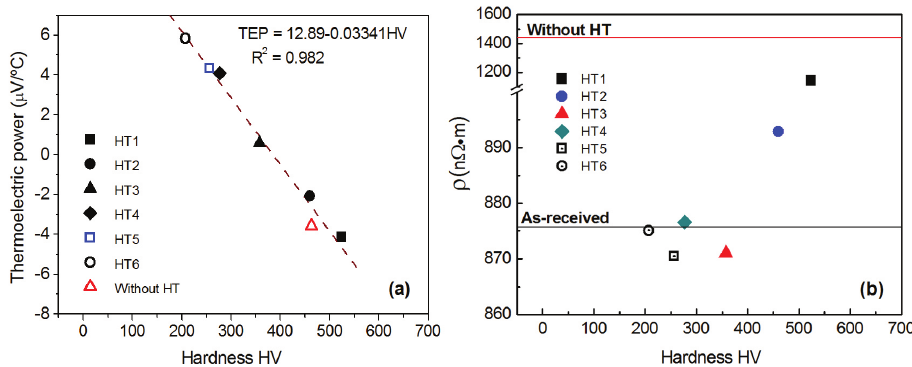
Figure 7. (a-b) TEP and ρ vs. microhardness respectively for each